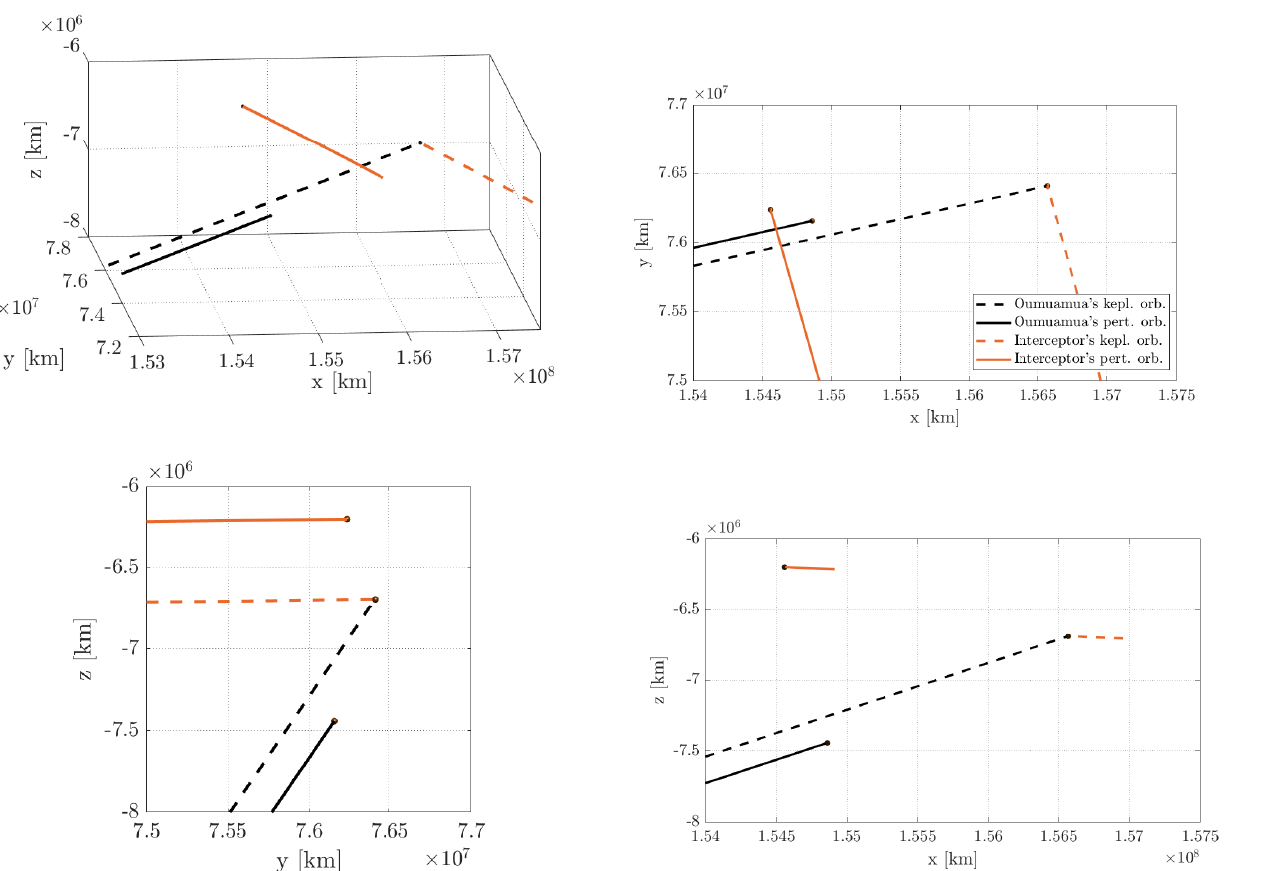
Figure 7. Trajectories of the ’Oumuamua (black) and the interceptor (orange) without perturbations (dashed line) and with perturbations (solid line). All units are given in km.